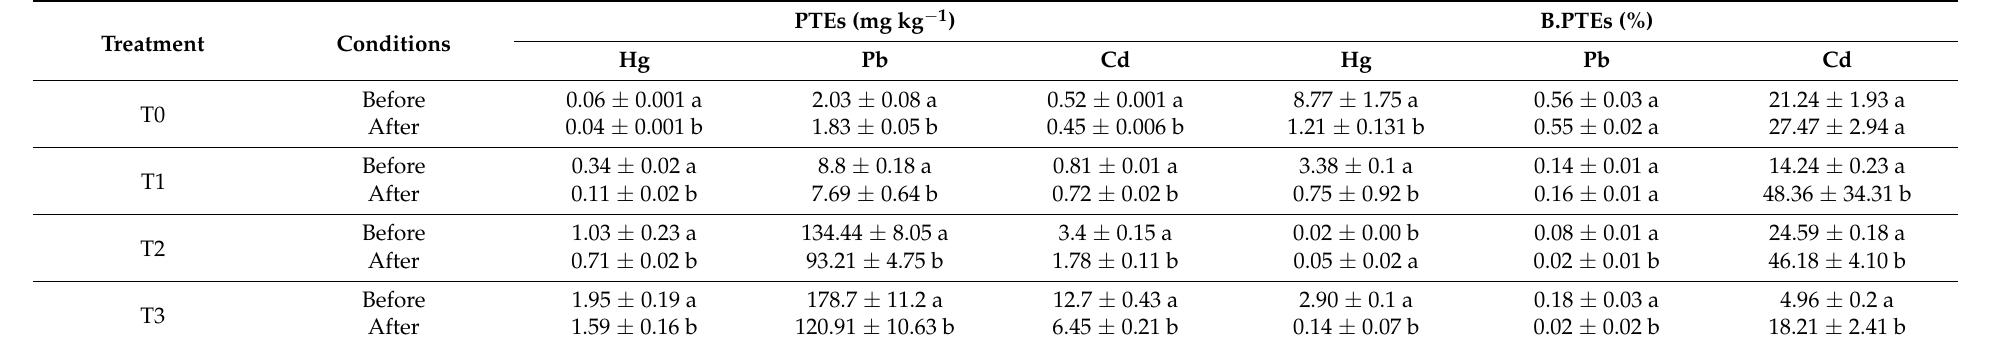
Table 2. Concentration and bioavailability of Hg, Pb, and Cd in soils before and after phytoremediation process.